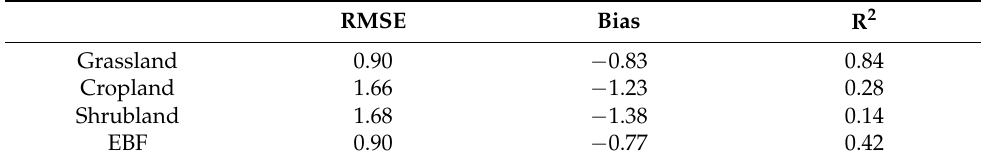
Figure 6. Validation result of MuSyQ LAI with reference LAI. The black dashed line indicates a 1:1 relationship and the solid line shows the linear regression between the reference LAI and MuSyQ LAI.